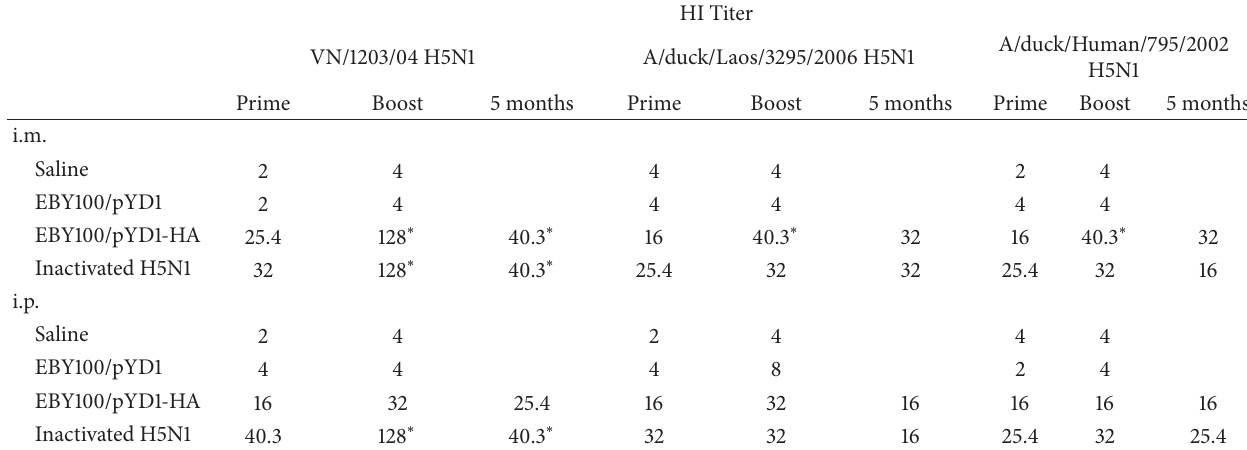
Table 1: Cross-reactivity of yeast vaccine immunized mice sera against divergent H5N1